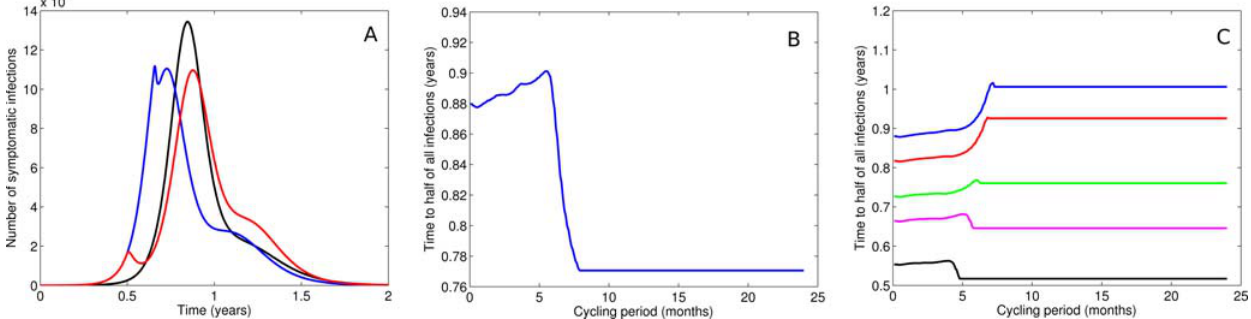
Figure 8. Analysis of the two drug cycling strategy. a. Epidemic curves with a 90/10 stockpile, for random allocation (black), using the 90% stockpile first (blue) and using the 10% stockpile first (red). Using the 90% stockpile first results in a poor outcome. Using the 10% stockpile first results in a slightly improved outcome compared to a random allocation strategy. b. Time to median infection ( t med ) vs cycling period for a 90/10 stockpile. The 90% drug is used first. If the switch is not made soon enough, the time to median infection drops below the time in a random allocation strategy. c. Time to median infection ( t med ) vs cycling period for a 50/50 stockpile. From top to bottom, the fitness of the resistant strain(s) is subtly increasing ( w =0.8, 0.81, 0.83, 0.85, 0.9). As the cycling period increases, the delay increases until a threshold is reached. Beyond the threshold the time to median infection may be greater than or less than the time for a random allocation strategy (cycling period approaching zero).